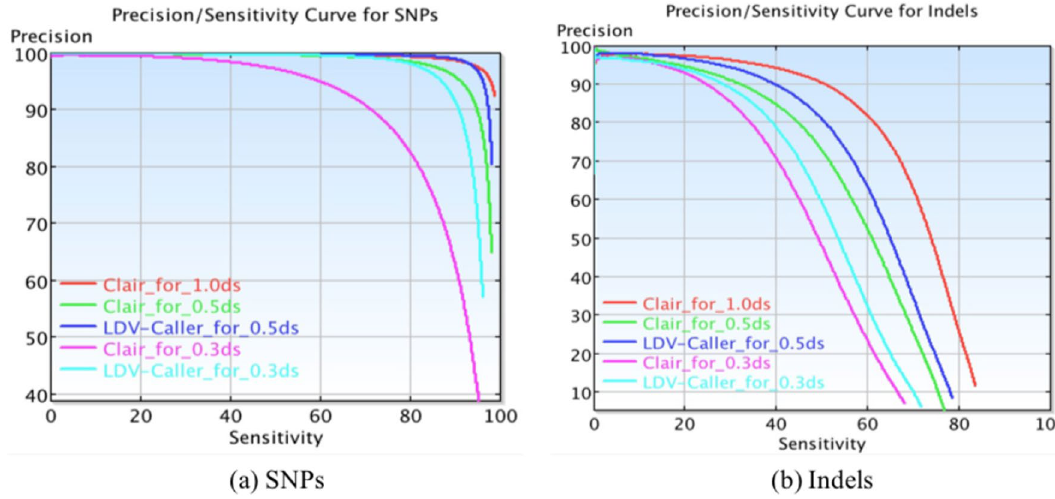
Figure 3. Precision/Sensitivity curves for SNPs and Indels on